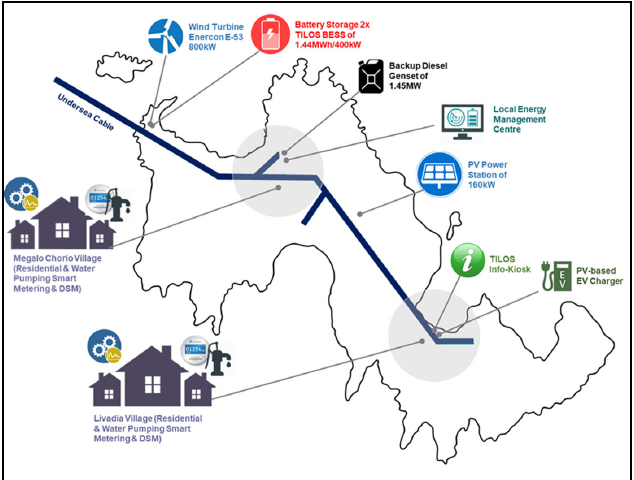
Figure 14. Description of Tilos island microgrid and geographical location of main assets.